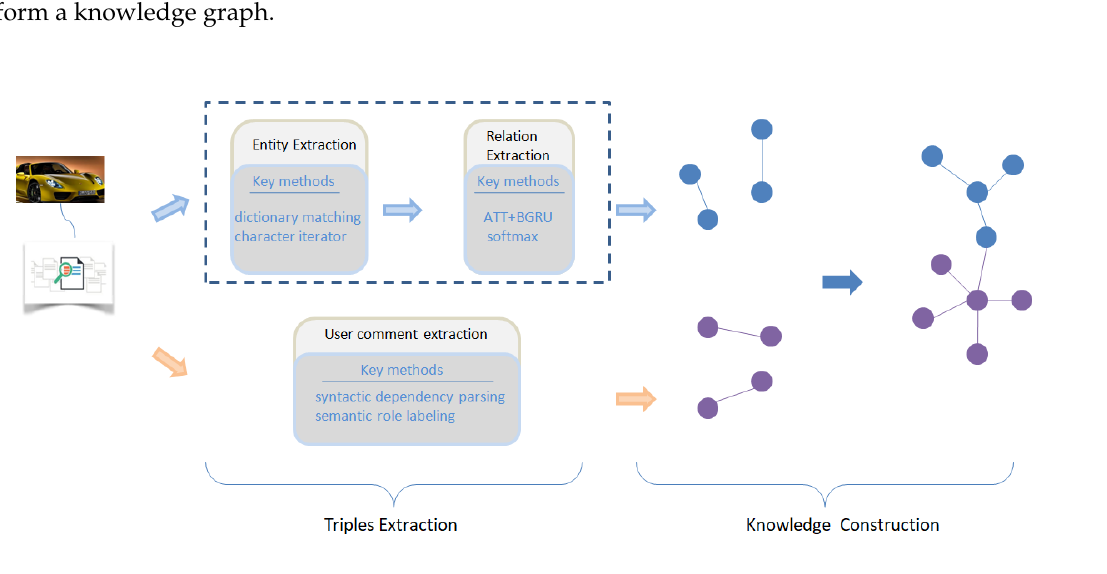
Figure 1. The pipeline of the method.